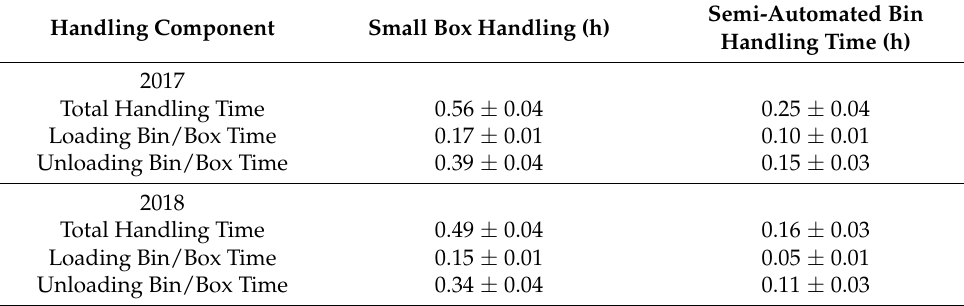
Table 4. Breakdown of total handling time for 2017 and